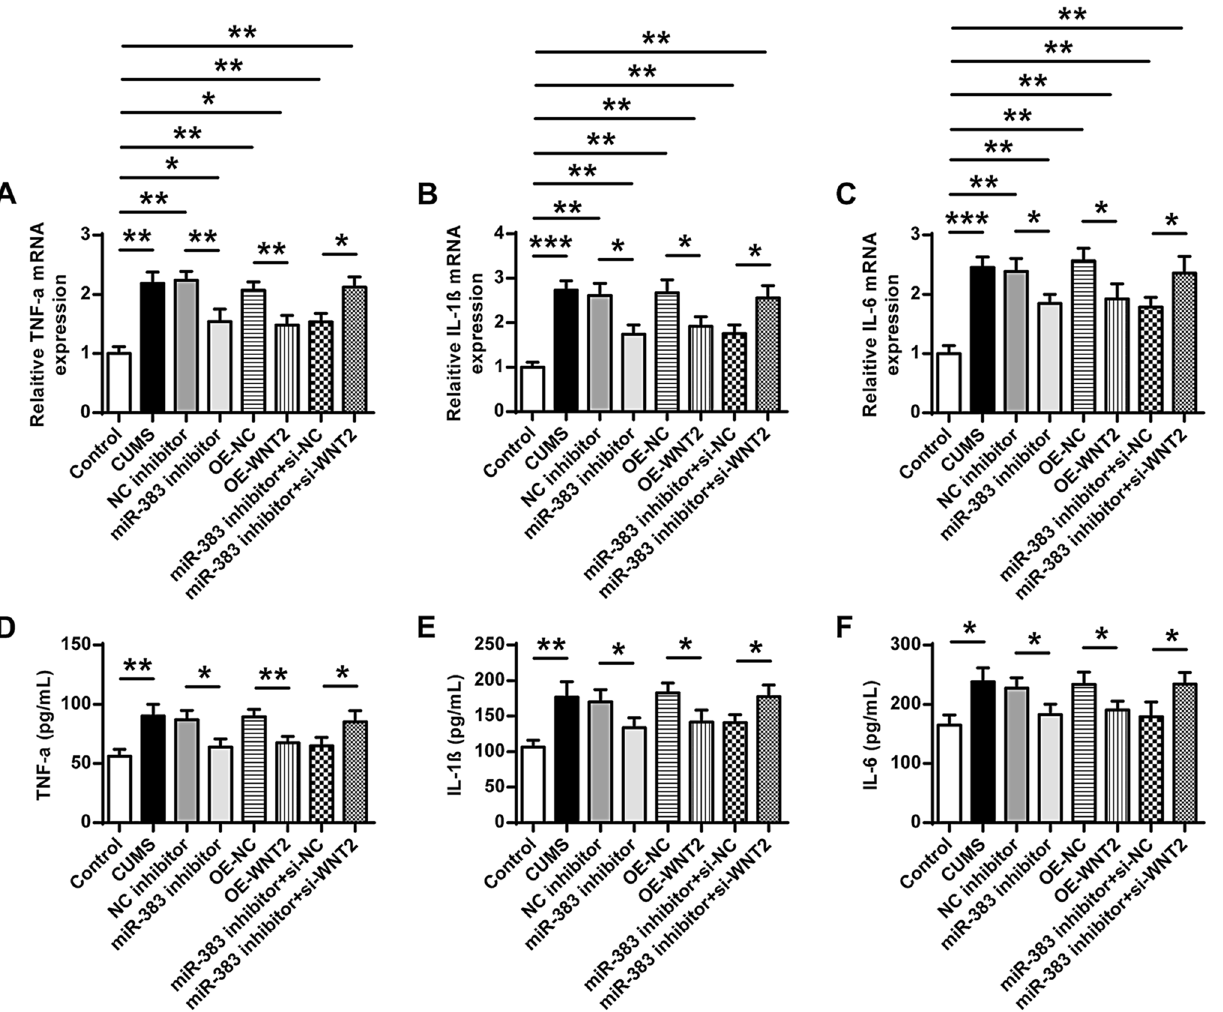
Figure 7. Downregulation of miR-383 or upregulation of Wnt2 attenuated inflammatory response in CUMS- induced rats. ( A – C ) The mRNA levels of TNF-α ( A ), IL-1β ( B ) and IL-6 ( C ) in hippocampal tissues of rats in different groups were evaluated by qRT-PCR. ( D – F ) The protein concentrations of TNF-α ( D ), IL-1β ( E ) and IL-6 ( F ) in hippocampal tissues of rats in different groups were evaluated by ELISA assy. N = 6. Data were presented as mean ± SD and each experiment was repeated three times. * P < 0.05, ** P < 0.01, *** P <